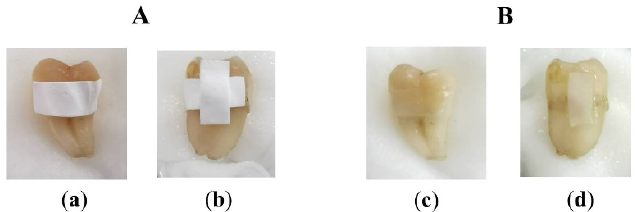
Figure 7. The photographs of tooth sample before ( A ) and after ( B ) 8 h of bleaching test; ENFs in horizontal direction ( a , c ) and ENFs in horizontal and vertical directions ( b , d ).